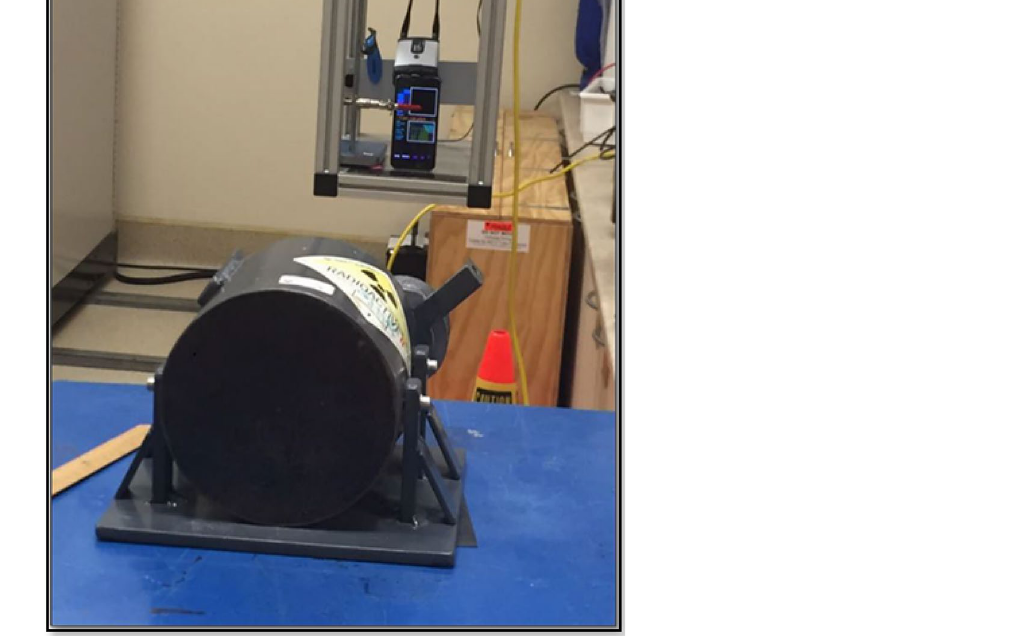
Figure 2. Irradiation and measurement